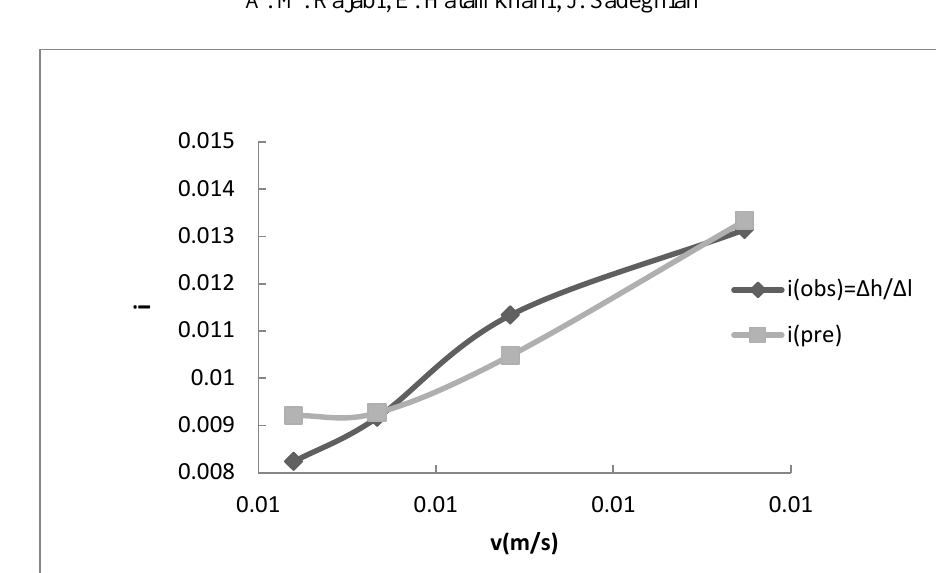
Figure 4. i-v curve for the depth of 85 cm and levels of 20 cm